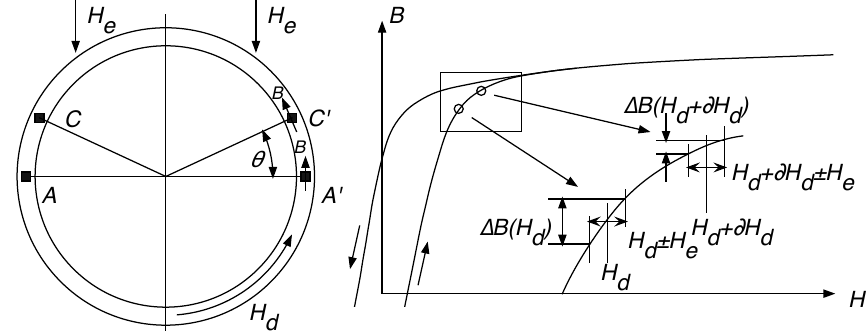
Figure 4. Ring core schematic and B − H loop detail.